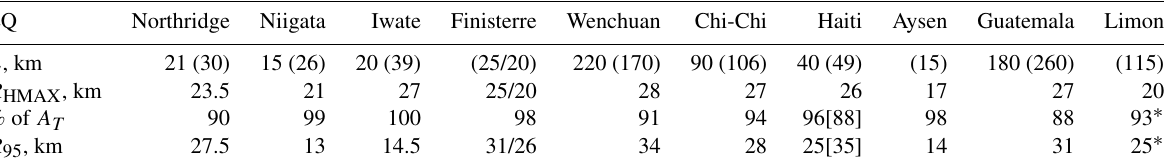
Table 2. Summary of the emission length L , the maximum horizontal radius for landsliding R HMAX , the landsliding included in the predic- tion (% of A T ), and the distance from the emission line containing 95% of the total landslide area, R 95 . In parentheses we give the values of L derived from rupture length scaling with moment (Eq. 3) that were used when we could not access a rupture slip model. For the Haiti earthquake we show the results from the inventory of Gorum et al. (2013) and of Harp et al. (2016) (in parentheses). We use the two largest shocks to model the Finisterre event. ∗ For the Limon earthquake some landslides in the most affected area could not be delineated and the total area is underestimated. Therefore we likely underestimate the amount of landsliding within the model prediction and overestimate R 95 , that may actually be smaller than R HMAX .